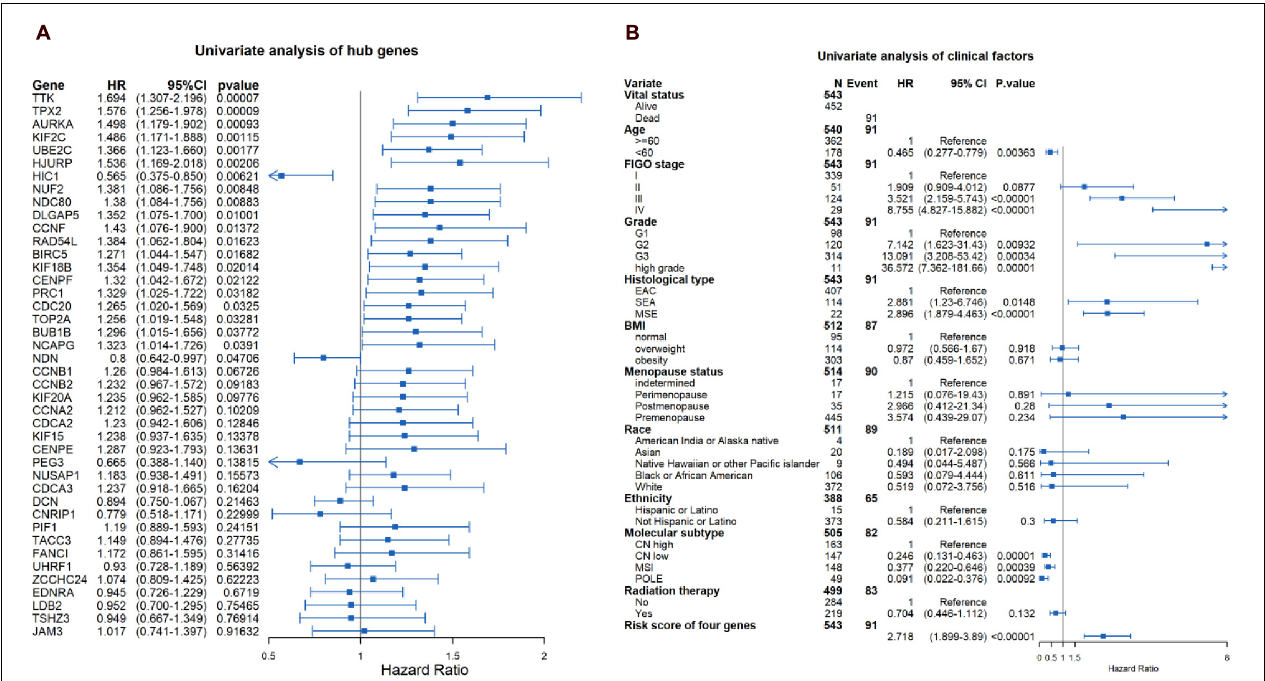
FIGURE 8 | Univariate analysis of the hub genes (A) and clinical factors (B) in the UCEC dataset.